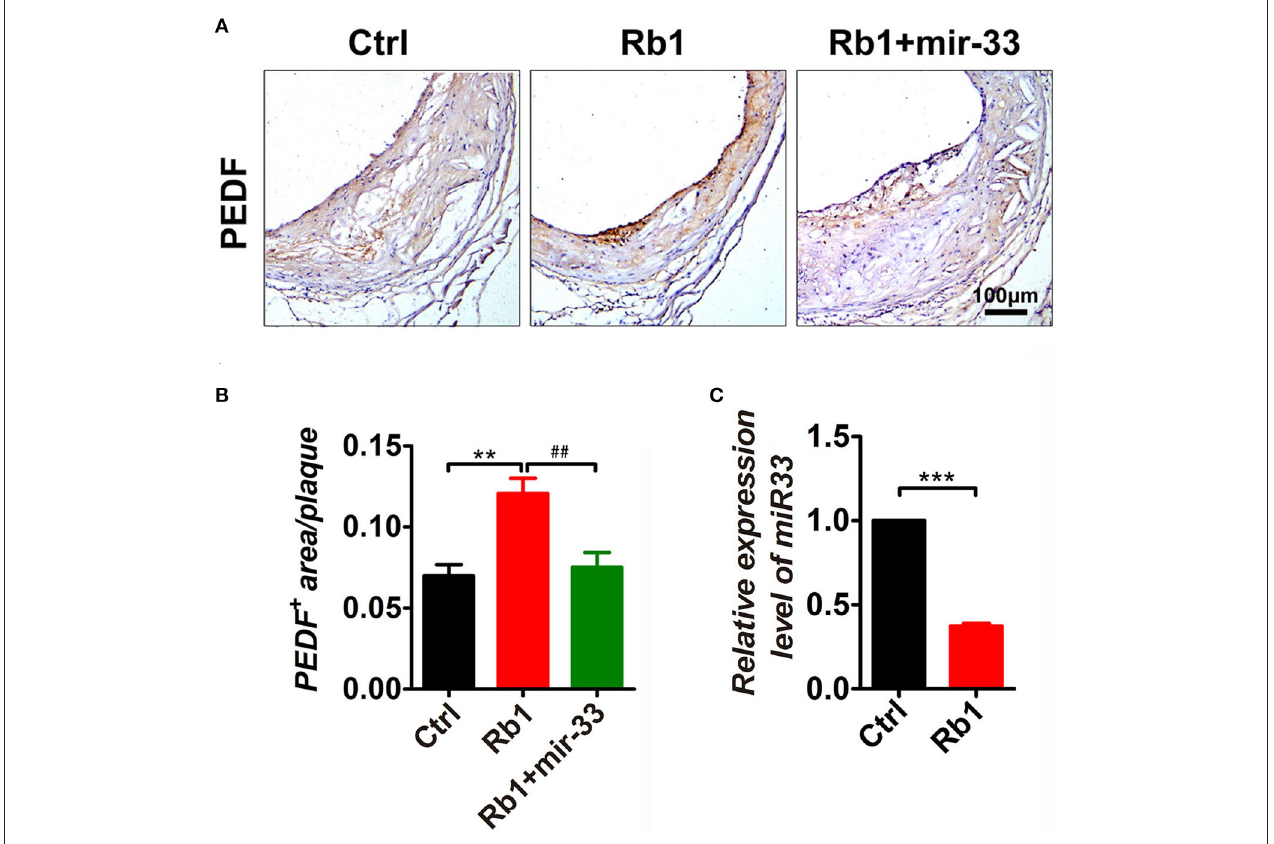
FIGURE 5 | miR-33 was involved in Rb 1 -induced PEDF expression in AS plaque in apoE − / − mice. (A) Immuno-histological analysis of cross sectional aorta roots of control group, Rb 1 -treated group as well as Rb 1 + miR-33 treated apoE − / − mice, by staining with anti-PEDF ( n = 14 ∼ 15/group). (B) Quantification of PEDF positive area vs. total cross sectional plaque areas of control group, Rb 1 -treated group as well as Rb 1 + miR-33 treated apoE − / − mice ( n = 14 ∼ 15/group), one-way ANOVA. ** p < 0.01; ## p < 0.01. (C) The expression levels of miR-33 of control group and Rb 1 treated group ( n = 4/group). *** p < 0.001, student’s